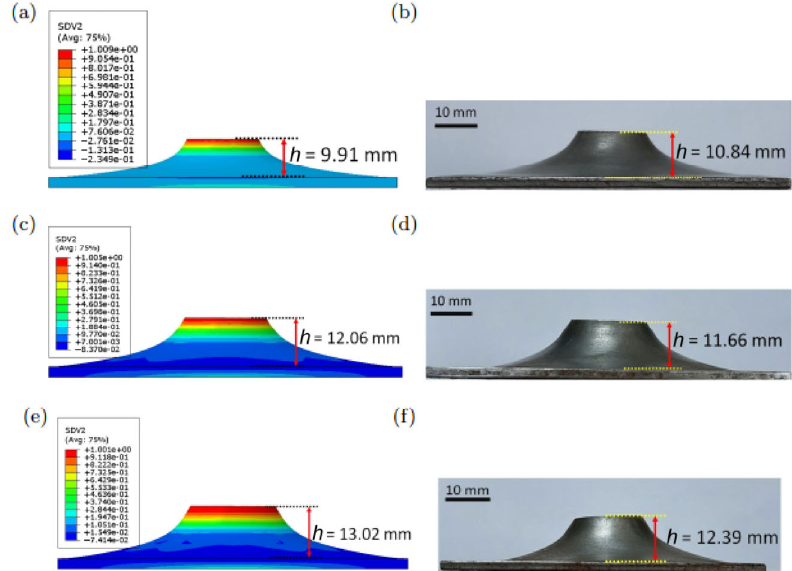
Fig. 12 Comparison of deformed HET specimen at the point of fracture. (a) Finite element method (FEM): monotonically, (b) experiment: monotonically, (c) FEM: interrupted loading at 50% punch travel, (d) experiment: interrupted loading at 50% punch travel, (e) FEM: interrupted loading at 70% punch travel, and (f) experiment: interrupted loading at 70% punch travel for 60